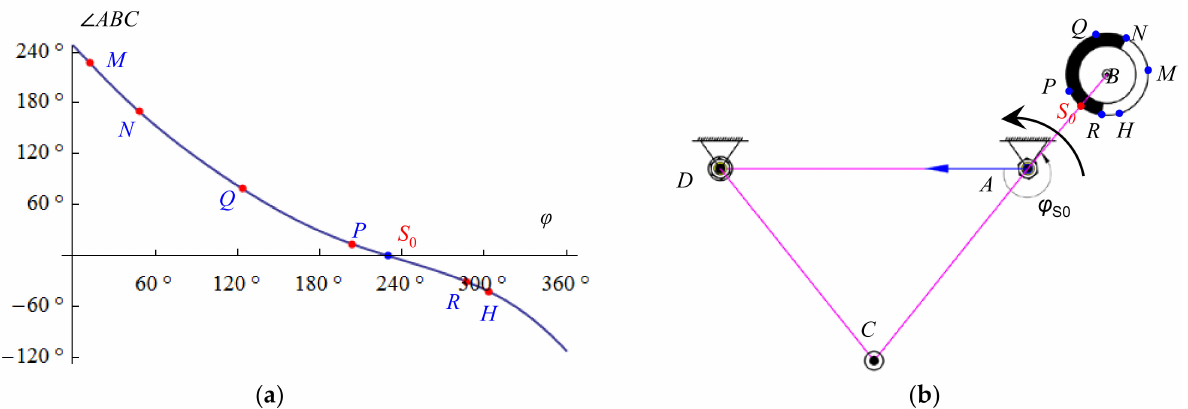
Figure 8. The organization of the working sequence between the crank rocker assembly and seedling clamping assembly. ( a ) Relationship between ∠ ABC and the independent variable ϕ . ( b ) Initial work status. Note: A , B , C , D , hinge points of each bar consistent with the symbols in Figure 4; P , the uppermost point of the planting track; M , the deepest point of the planting track; N , the farthest point of the planting track; R, the nearest point of the planting track; H, the penetrating point; Q , the unearthed point; S 0 , the initial position; ϕ S0 , the angle value of the independent variable ϕ at the initial